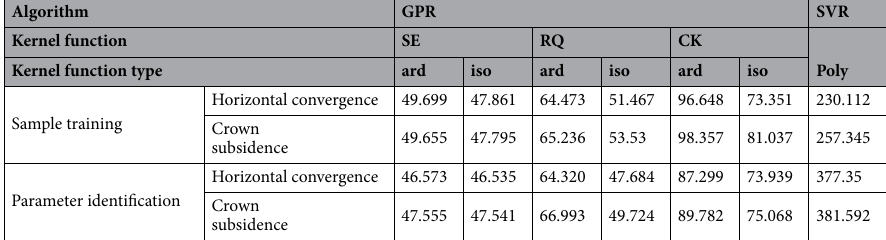
Table 12. Comparison of the calculation times during different stages (unit: